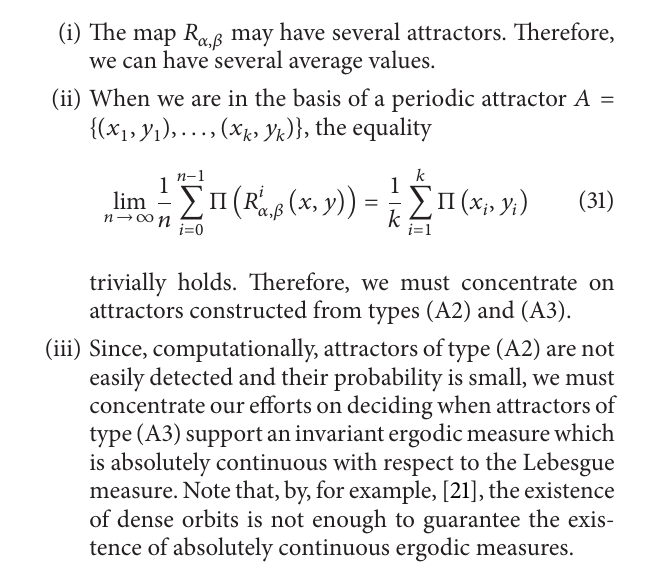
exponent for the parametric region. Figure 14 shows the maximum of {𝜆(𝑔 𝛽 ∘ 𝑓 𝛼 )(𝑐 𝑖 ), 𝑖 = 1, 2} , where 𝑐 1 and 𝑐 2 are the turning points that have different forward images by 𝑔 𝛽 ∘ 𝑓 𝛼